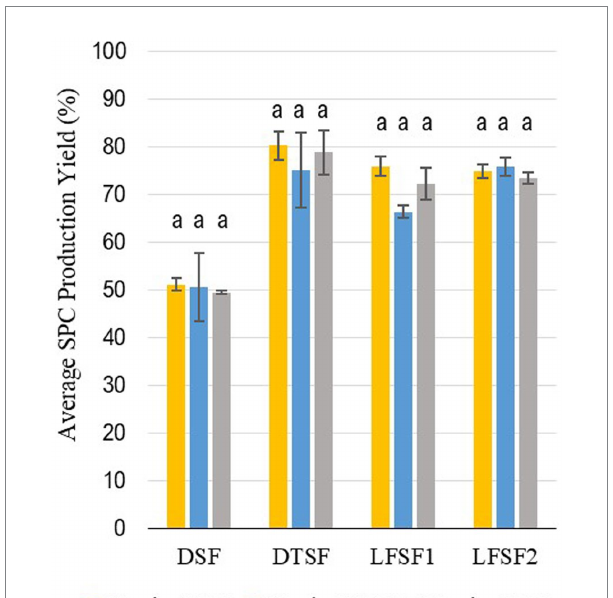
FIGURE 1 Average yields of SPC as prepared from defatted soy flour (DSF), defatted toasted soy flour (DTSF), low-fat soy flour 1 (LFSF1), and low-fat soy flour 2 (LFSF2) after different mixing times and temperatures. Bars represent means ± SD. Different superscript letters within each type of material group represent statistical differences (One-Way ANOVA and Fisher’s LSD test; p <